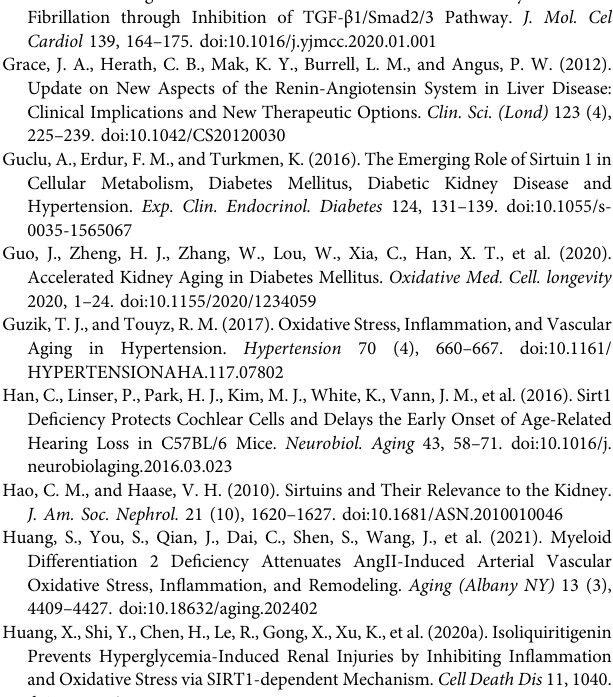
Supplementary Figure 2 | Quality control of C. cicadae was evaluated by HPLC GC/MS analysis.